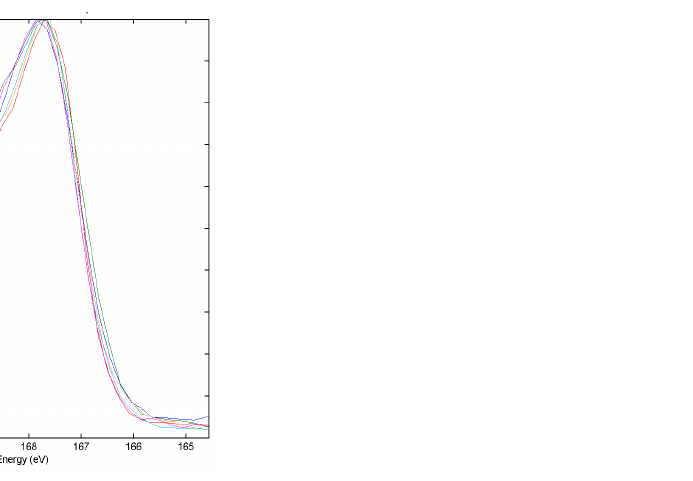
Table 3. Assignments [15] and % areas for S 2p 3/2 and S 2p 1/2 peaks as determined by curve-fitting the spectra in Figure 6.